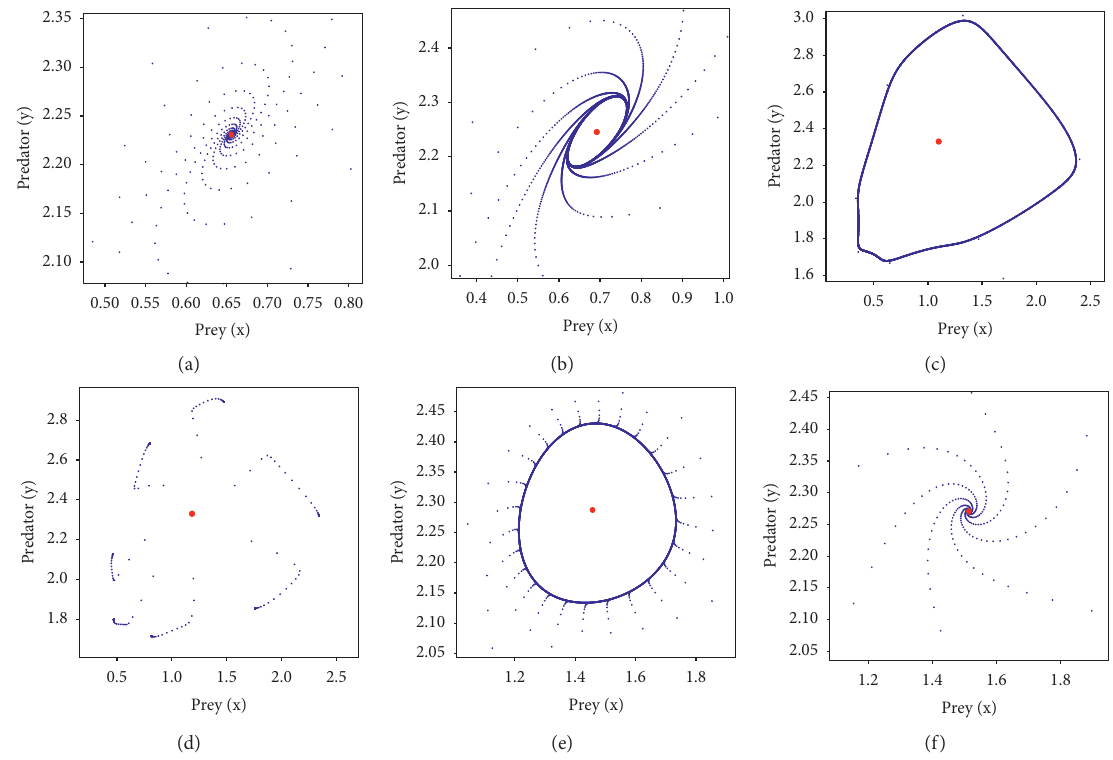
Figure 5: The phase portraits for system (5) with r � 4, a � 1 . 15, g � 2 . 7, b � 1 . 2, r � 1, h � 1 . 06, c � 1 . 9 (a) locally asymptotically stable 1 2 for m � 0 . 18; ((b), (c)) invariant circles for m � 0 . 2 , 0 . 5, (d) period-8 for m � 0 . 58, (e) invariant circle for m � 0 . 88, and (f) asymptotically stable for m � 0 . 95. The red points represent the interior equilibrium point E ∗ ( x ∗ , y ∗ ) , and its values are given in Table 2.